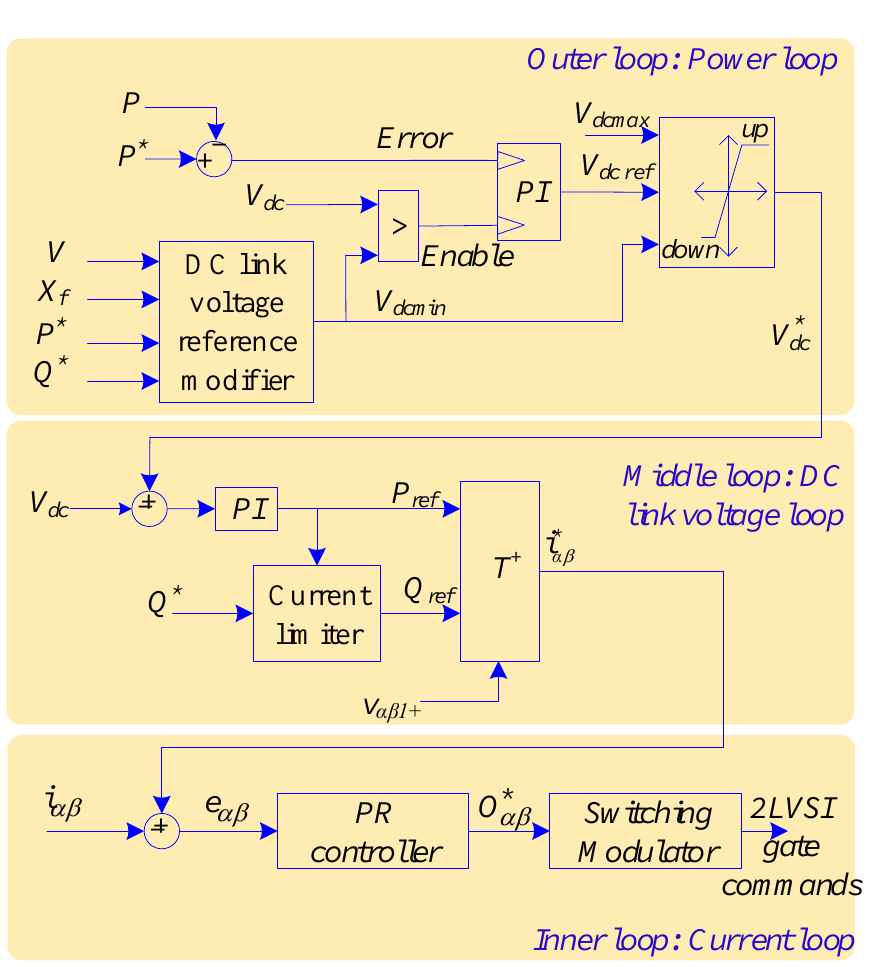
Figure 6. The proposed control scheme for the bioelectrochemical power-to-gas station.